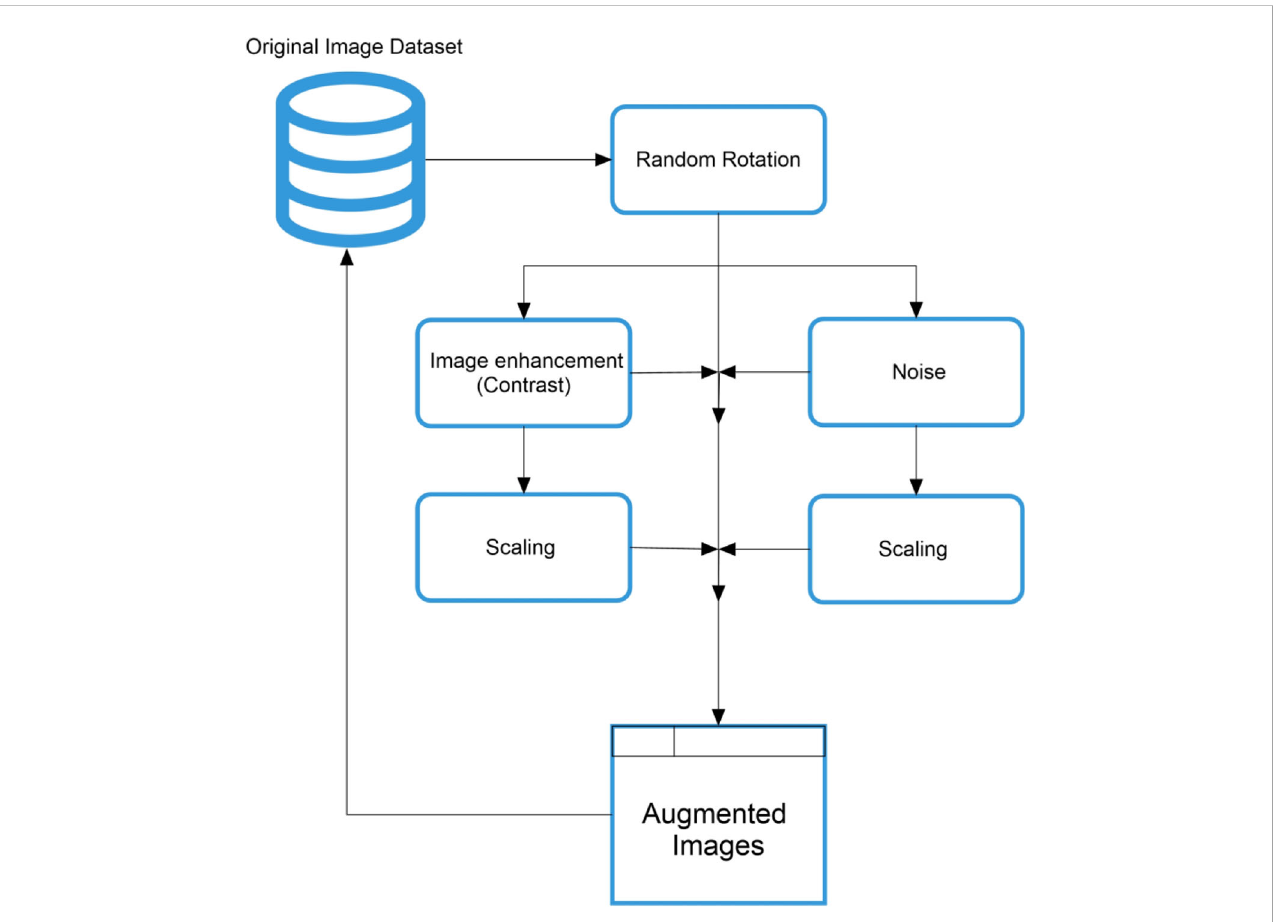
FIGURE 1 Proposed manipulation-based data augmentation